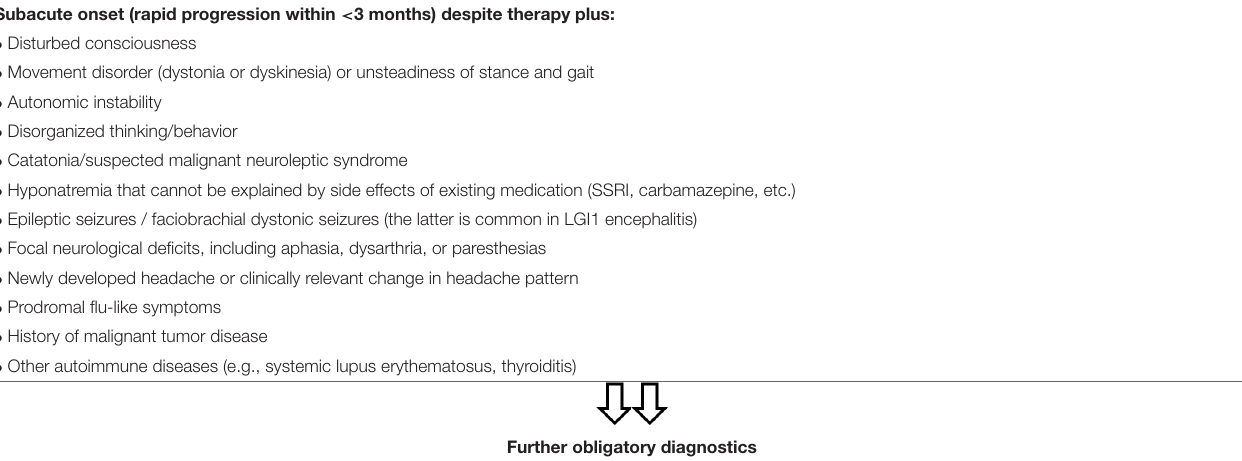
TABLE 1 | Warning signs of autoimmune encephalitis in patients with psychotic symptoms and step-by-step diagnosis (31, 56, 58). Subacute onset (rapid progression within < 3 months) despite therapy